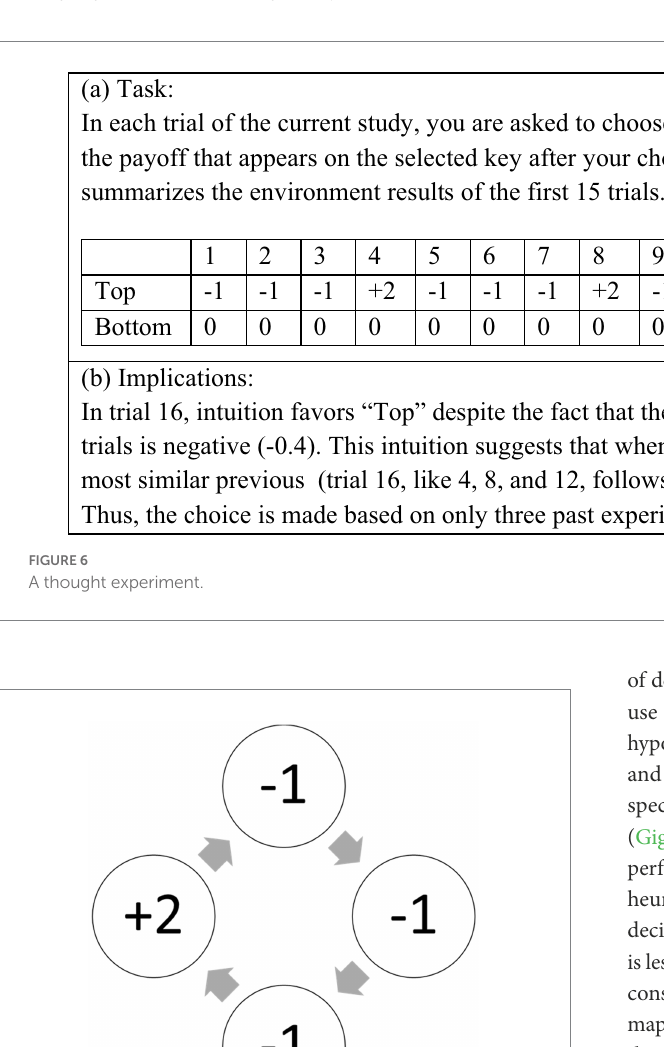
The table considers Trial 64 in the “disaster problem” of Figure 5 (“0 with certainty” or “10% to lose 10, gain of 1 otherwise), assuming that similarity is determined by the three recent payoffs from the risky option. It shows that when the recent payoff sequence includes a rare event, the number of similar past experiences decreases, and the probability of underweighting of the rare event (choosing the risky option) increases.